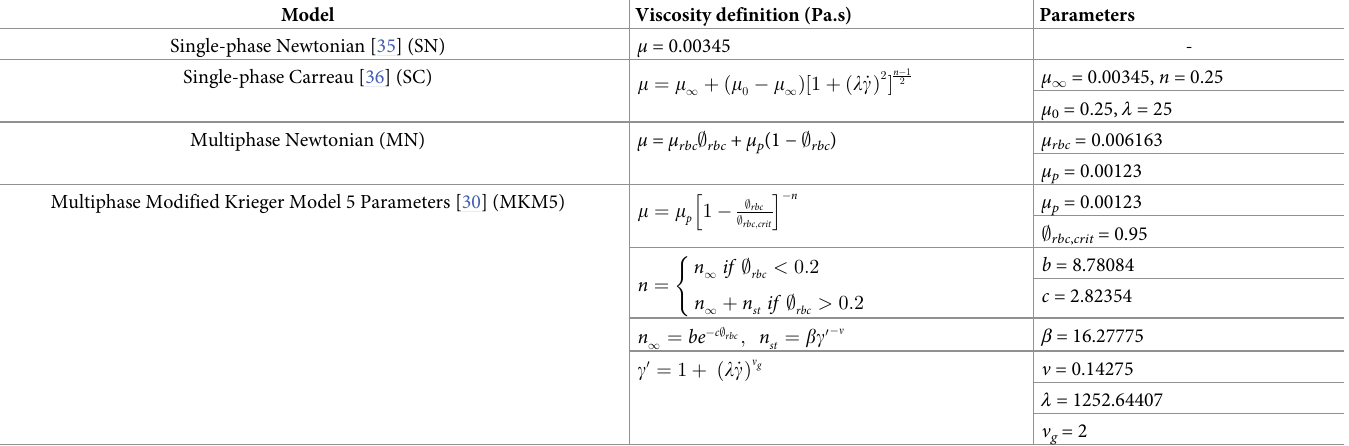
Table 1. Definitions for the rheological